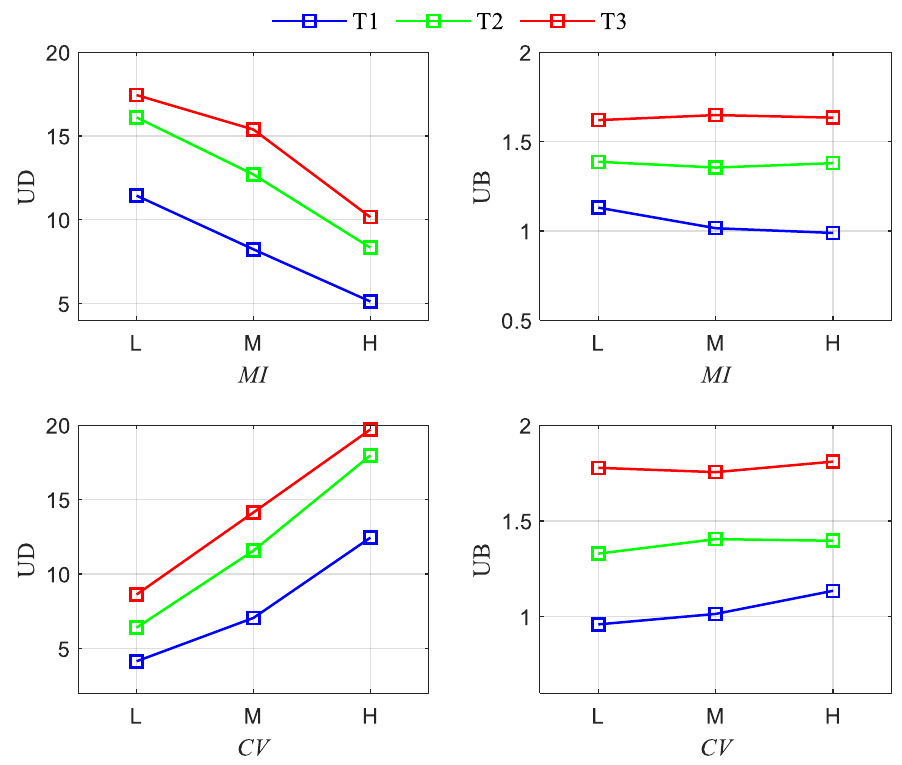
Figure 13. Relationship between radar rainfall uncertainty bands and rainfall spatial variability.